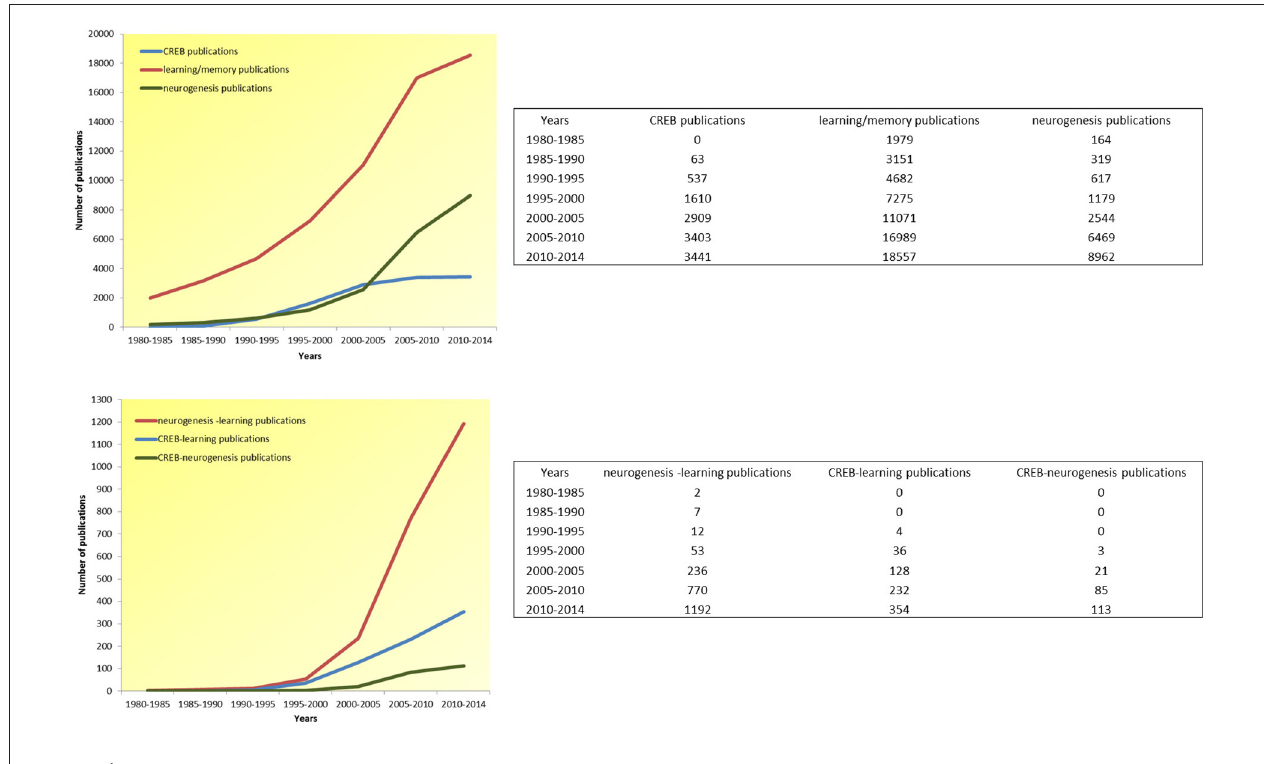
FIGURE 2 | Article publication trend in the last 34 years (1980–2014). In over three decades, there has been an exponential increase in the number of publications addressing all topics of interest here (i.e., CREB, learning-memory and neurogenesis), as well